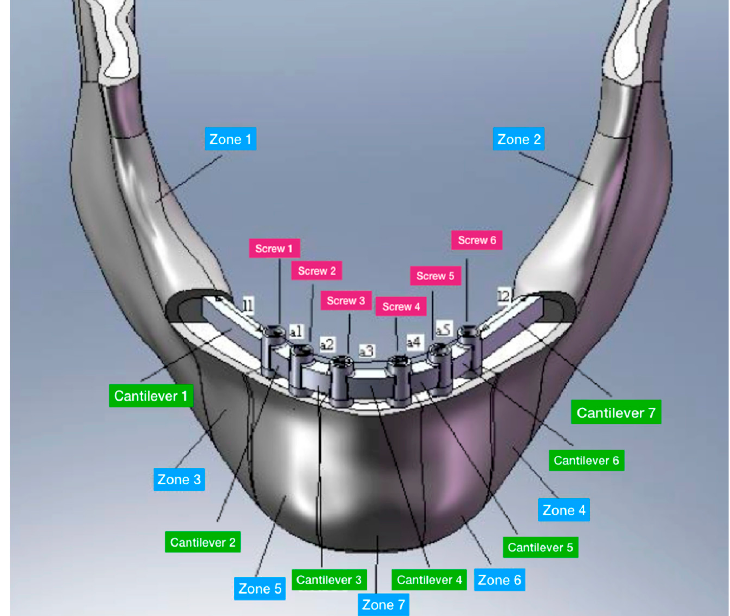
Figure 8. 3D model with the prosthesis structure: l1 and l2 represent the cantilever; a1, a2, a3, a4 and a5 represent the spaces between the dental implants.